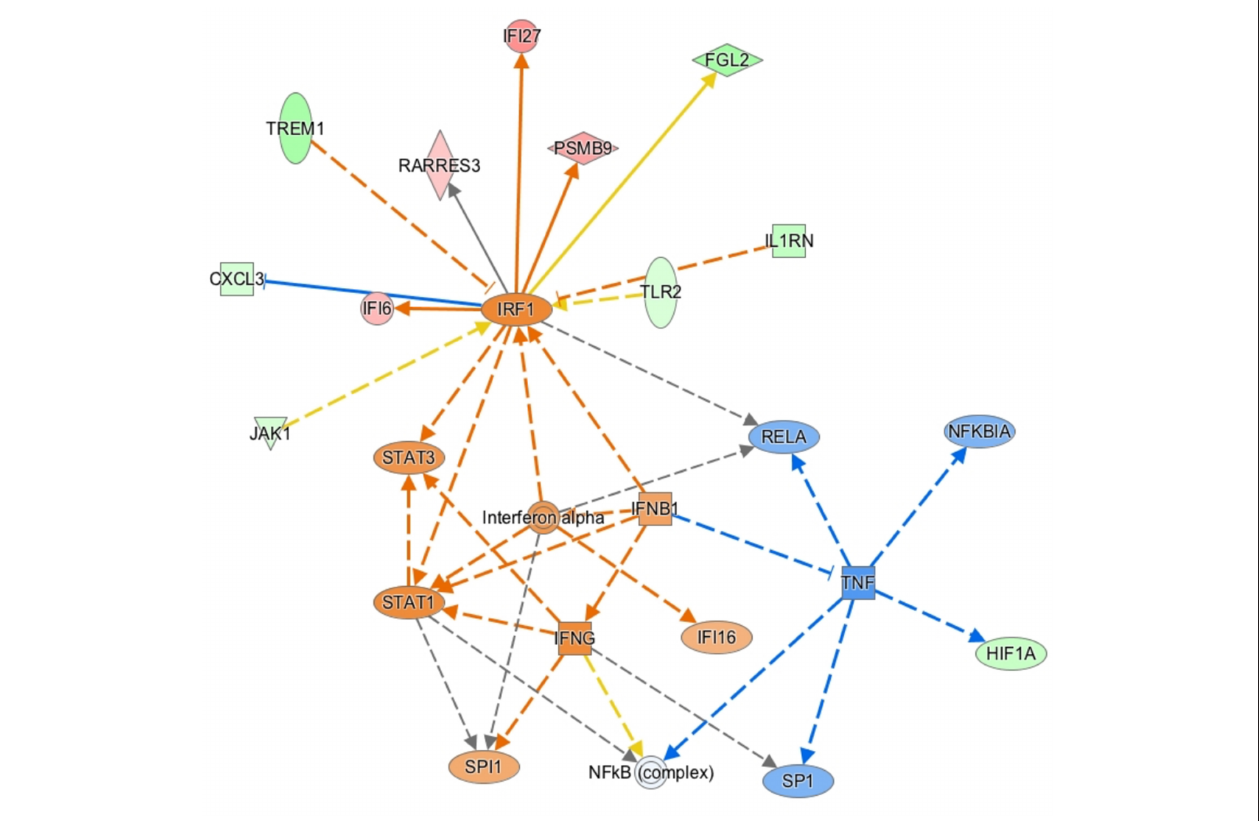
FIGURE 4 | Ingenuity pathway core analysis was used to identify enrichment in biological processes (ZIKV Infected vs. Uninfected). Statistically significant alterations in differentially expressed genes from SC-RNAseq analysis of decidua CD14 + cells are represented by labeled shapes depending on their molecular function. Expression and predicted activation levels determined by fold-change between ZIKV infected vs. uninfected are presented using the following convention on color scales with increasing saturation associated with a greater absolute fold-change value: red = increased detection in CD14 + cells from ZIKV infected decidua; green = decreased detection; orange = predicted activation. Predicted relationships are indicated by arrow-heads and blue lines to indicate predicted inhibition; yellow lines indicate inconsistent findings that make it difficult to predict outcomes of interactions.